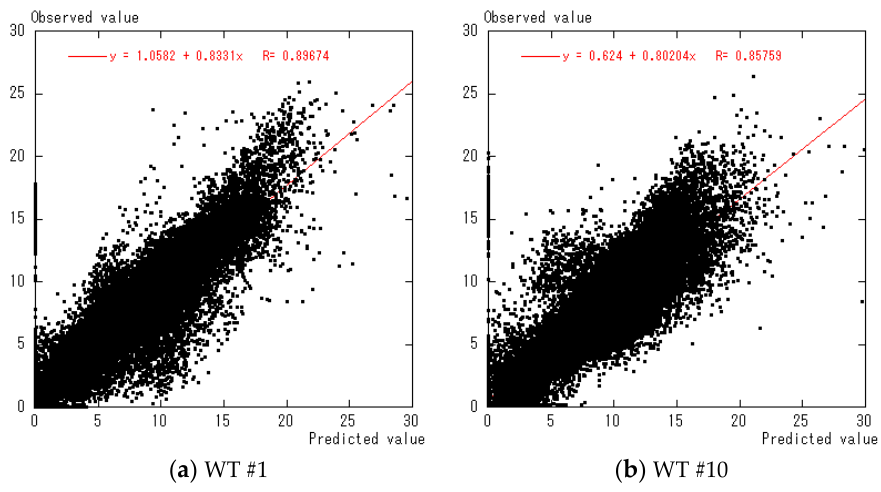
Figure 10. Scatter plots of observed and predicted wind speed, reference point: WT #4.